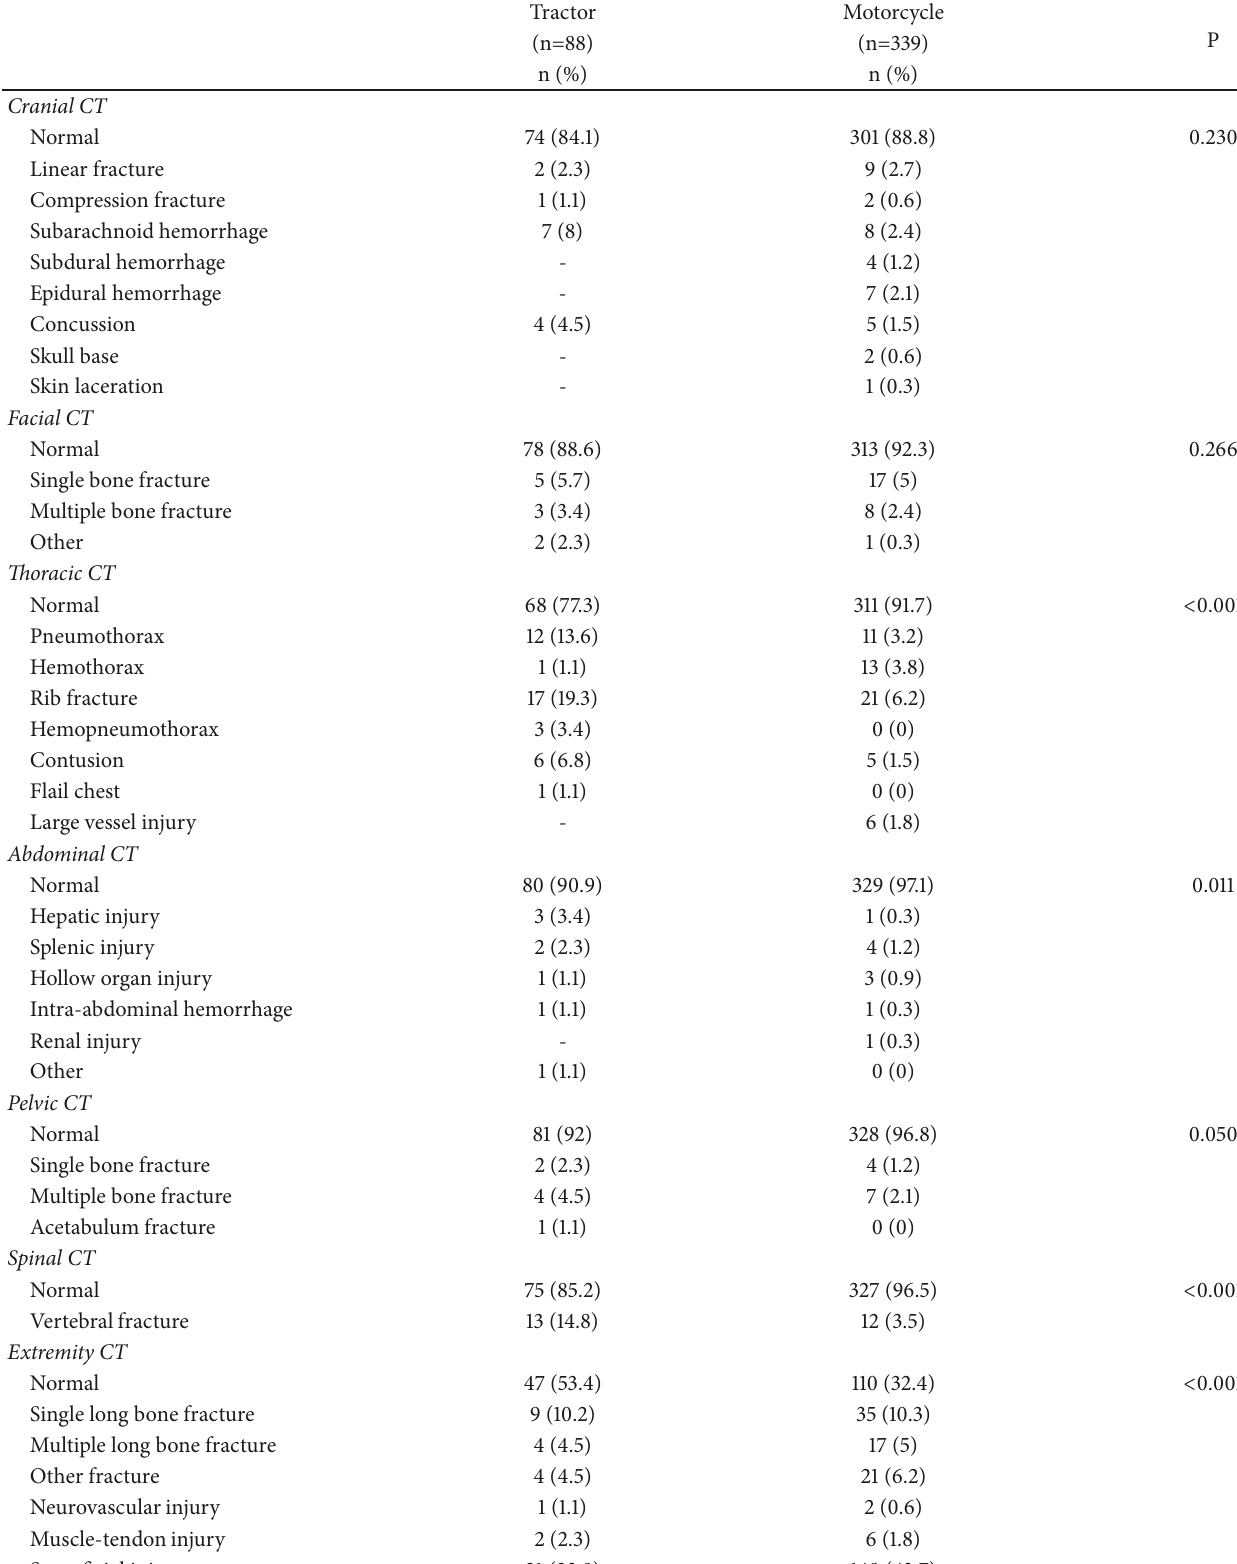
Table 3: Computerized tomography imaging